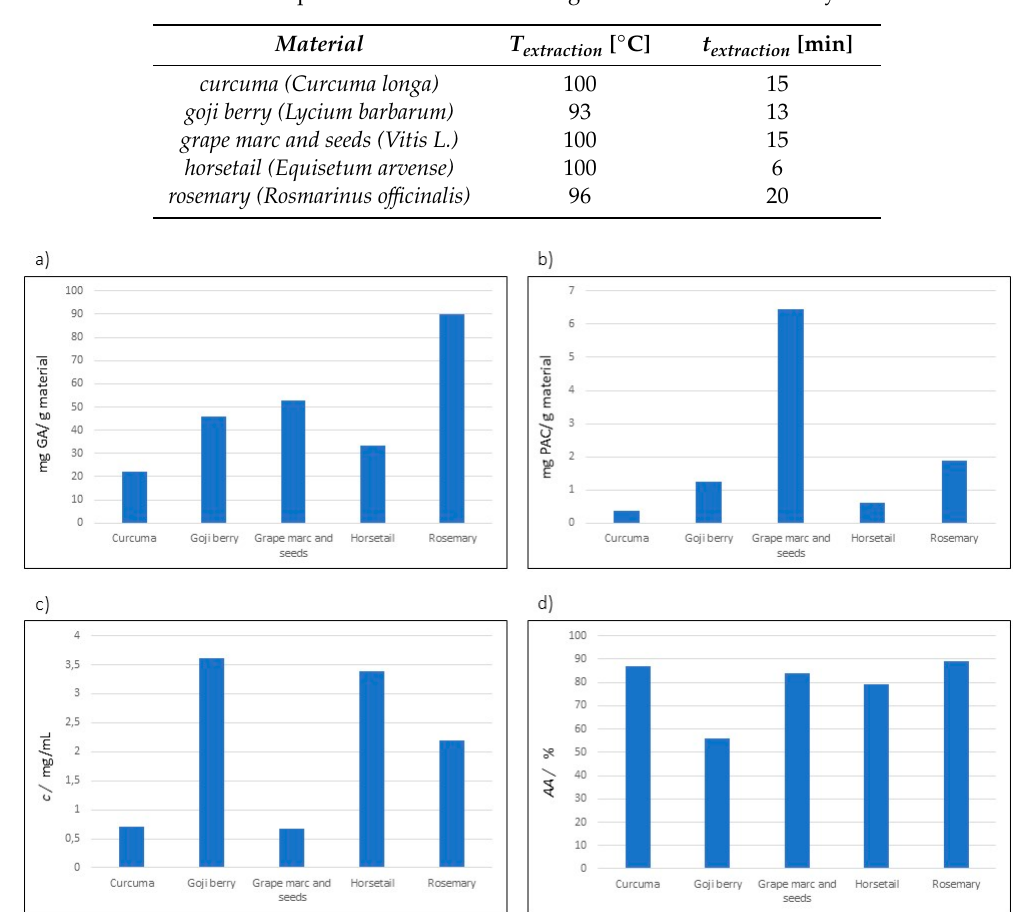
Table 1. Optimal conditions for the highest antioxidative